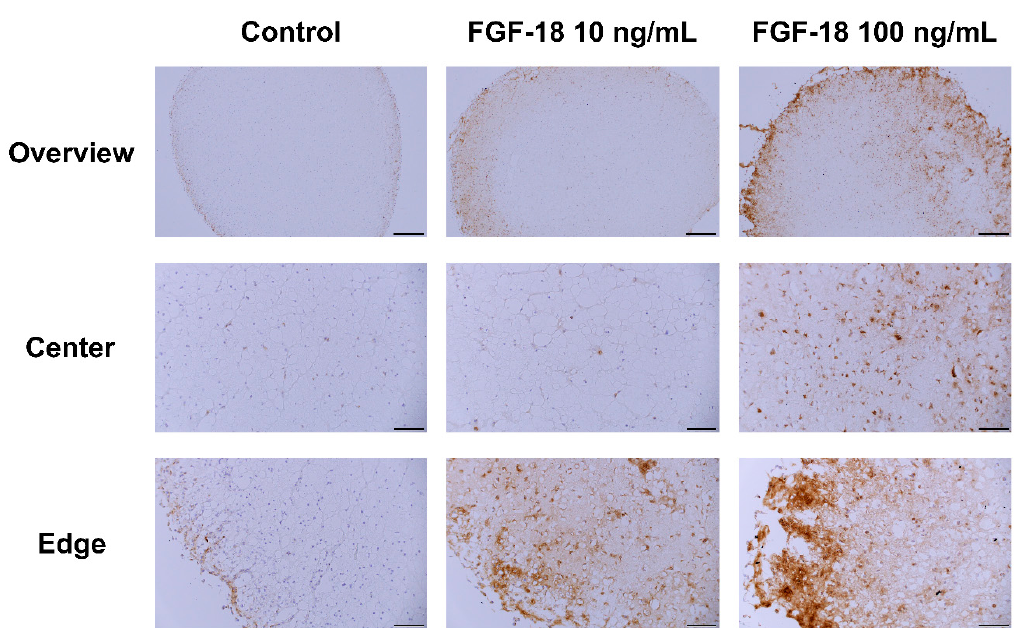
Figure 7. Aggrecan immunohistochemistry staining of bovine (healthy) nucleus pulposus cells encapsulated in FBG-HA hydrogel and stimulated with 0, 10, or 100 ng/mL FGF-18 after 14 days of culture. Scale bar: overview—500 µm, center and edge—100 µm.